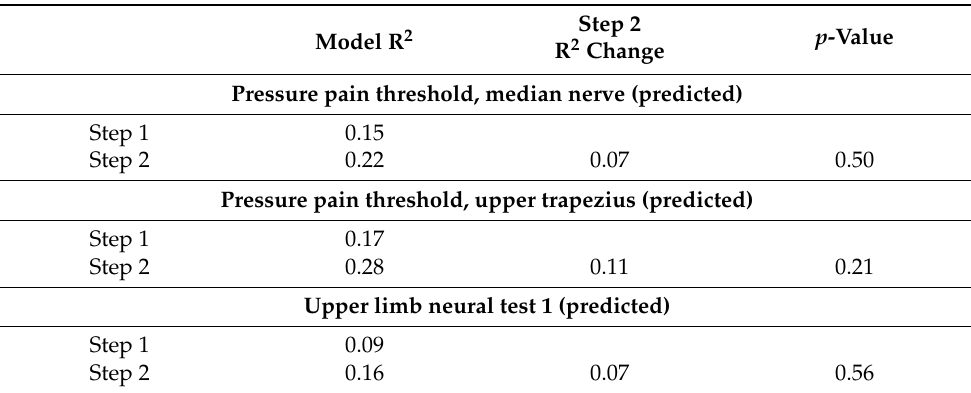
Table 5. Multiple linear regression analyses for prediction of pressure pain threshold and neural tension